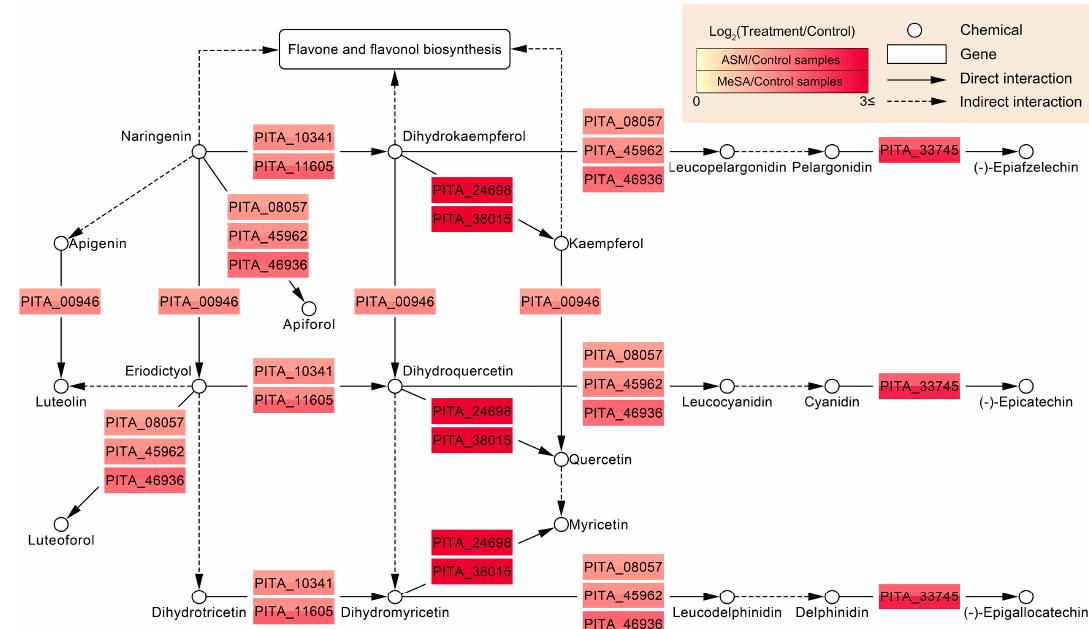
Figure 5. Molecular networks with expression changes in flavonoid biosynthesis. The nodes illustrate the type of molecules as follows: genes (coloured rectangles); biochemicals (circles); cognate pathway (white rectangle). The di ff erences in colour are indicative of the corresponding changes in log 2 (treatment / control) values from a minimum of 0 to a maximum of 3, where a value of 0 indicates the same expression level between treatment and control conditions. The direction of biosynthesis in a pathway is represented by arrows adjacent to the gene names.